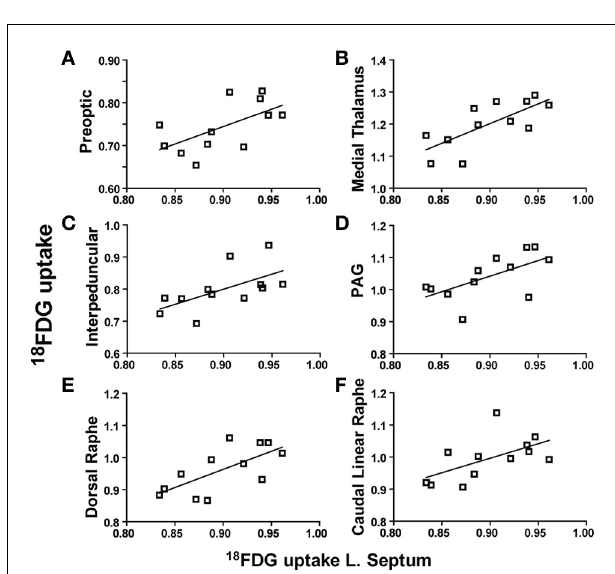
tegmental area (VTA) (E) , rostromedial tegmental nucleus (RMTg) (F) , interpeduncular nuclei (G) , dorsal raphe (H) , periaqueductal gray (PAG) (I) , central gray (J) , caudal linear raphe (K) , and subiculum transition area (L) .